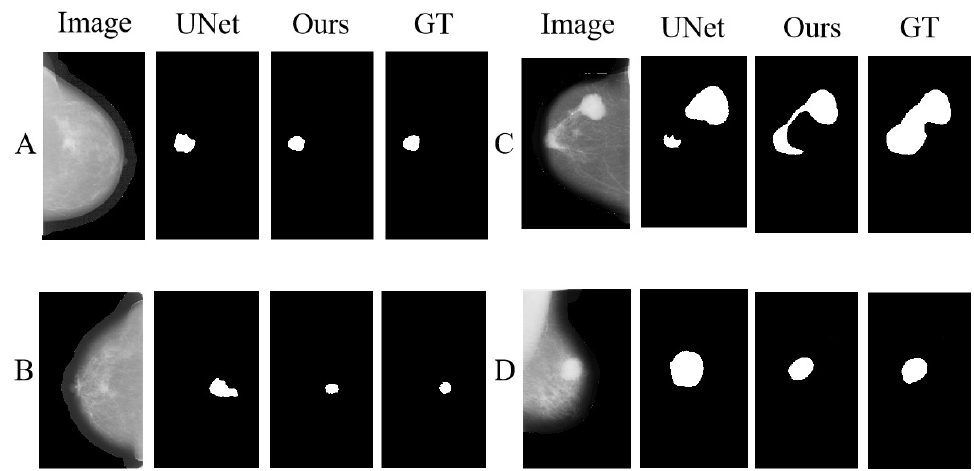
Figure 4. Qualitative comparisons between the segmentation results achieved by the proposed framework, the comparative method, and the ground truth. ( A – D ) refer to Breast-A, Breast-B, Breast-C and Breast-D datasets, respectively.